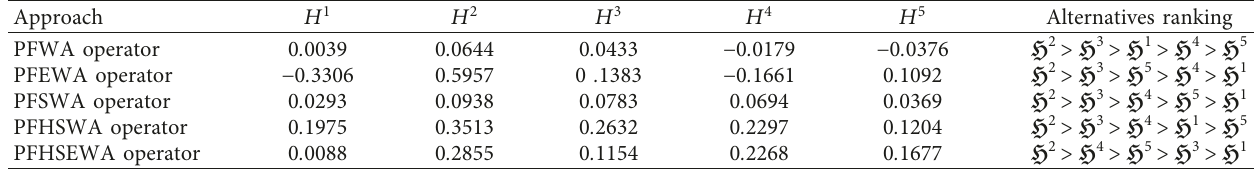
Table 7: Comparison of proposed operators with some existing operators.